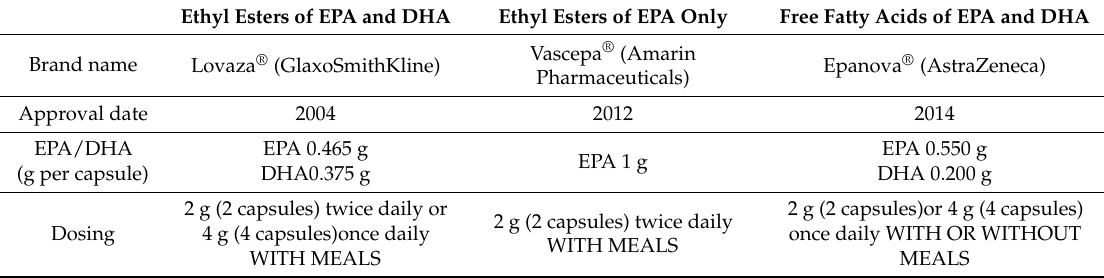
Table 3. ω -3 PUFA